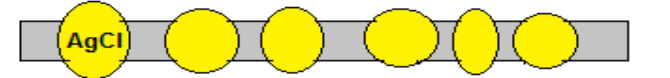
Figure 14. An inorganic AgCl anion exchange membrane based on AgCl grains in a polymer matrix.